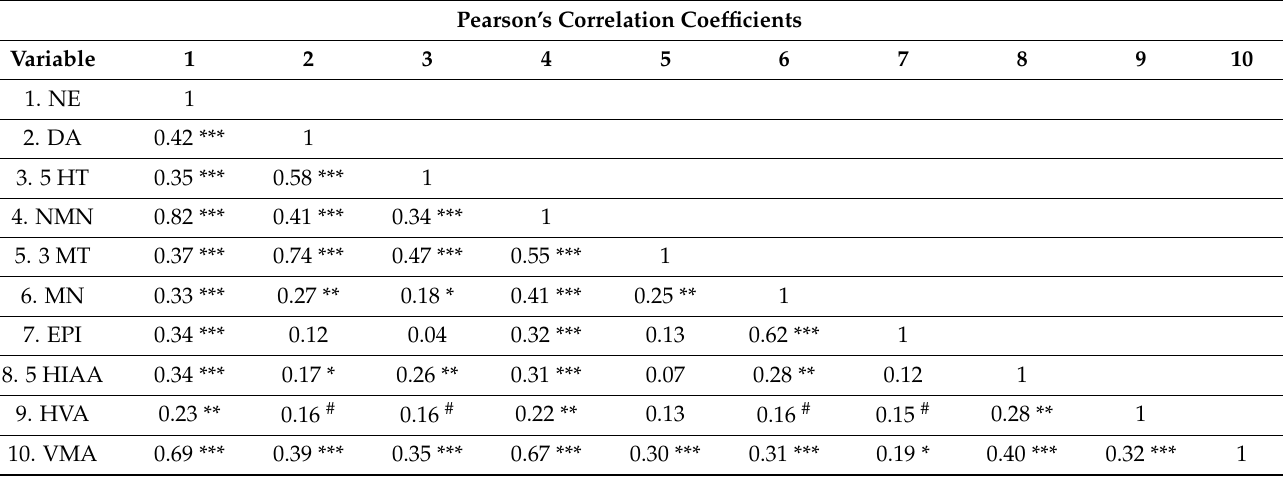
Table 3. Bivariate correlations and summary statistics for normalized catecholamines and their